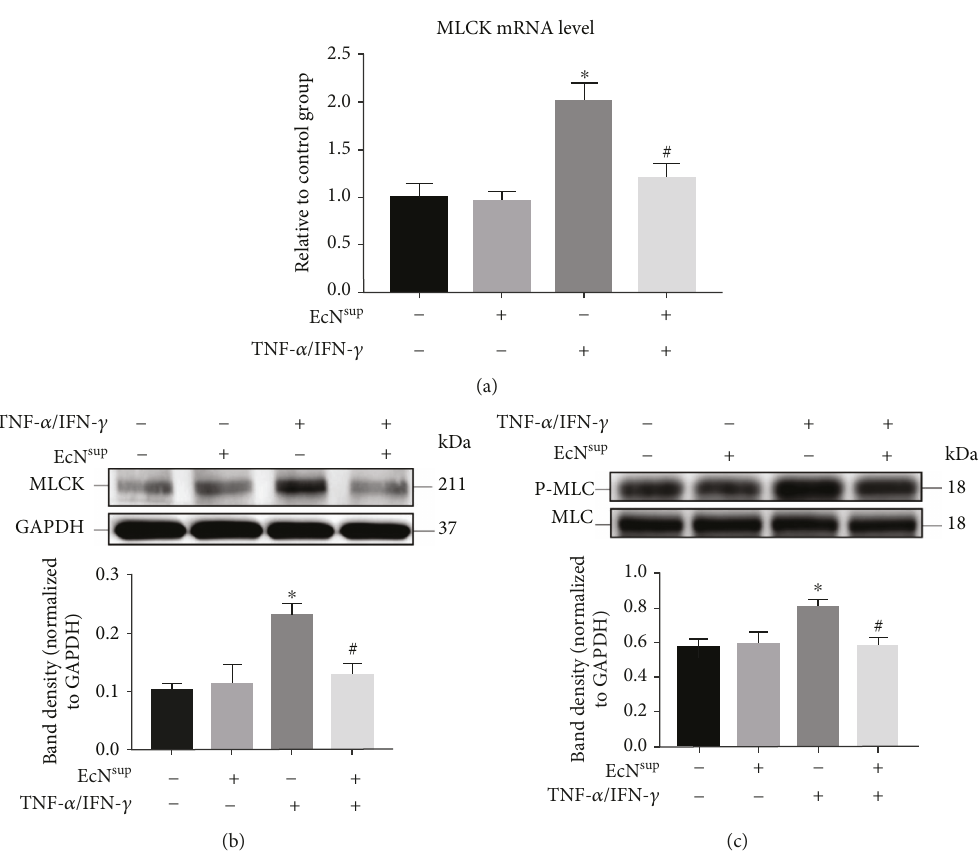
Figure 5: EcN sup inhibited the increased expression of MLCK and the phosphorylation of MLC induced by TNF- α /IFN- γ . (a) The RNA of monolayers was harvested after incubation for 48 h in the absence or presence of 10ng/mL TNF- α and 10 ng/mL IFN- γ with or without 100ng/mL EcN sup , and the expression level of MLCK mRNA was detected by RT-qPCR. (b, c) The total protein of monolayers was harvested after treatment as described in (a), and the expression level of proteins was detected by western blot assays. Results were expressed as the mean ± SEM ( n = 3 ). ∗ P < 0 05 vs. control. # P < 0 05 vs. TNF- α /IFN- γ